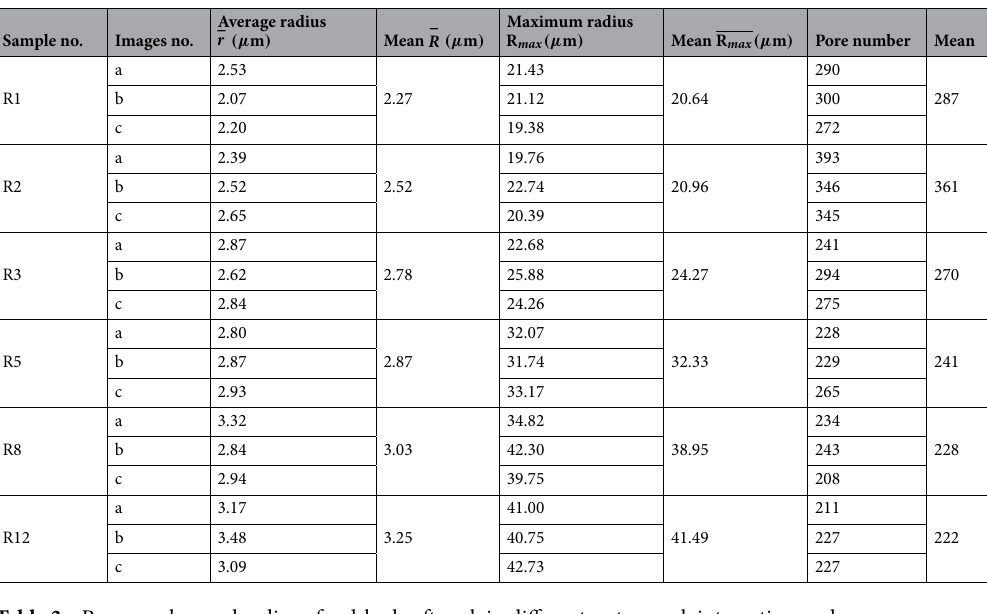
Table 3. Pore number and radius of red-bed soft rock in different water–rock interaction